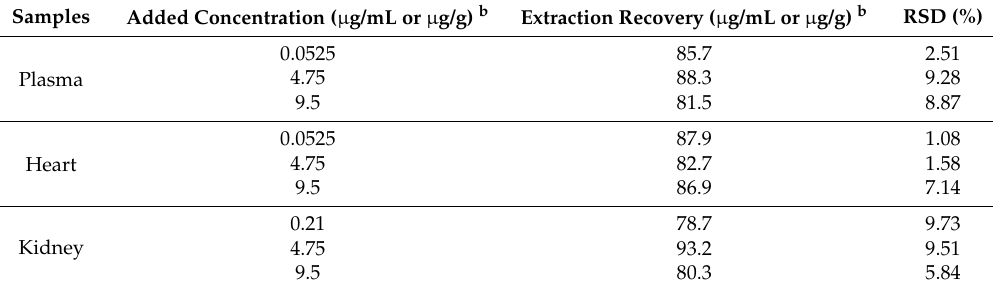
Table 3. Extraction recovery of baicalin in rabbit plasma and tissues a